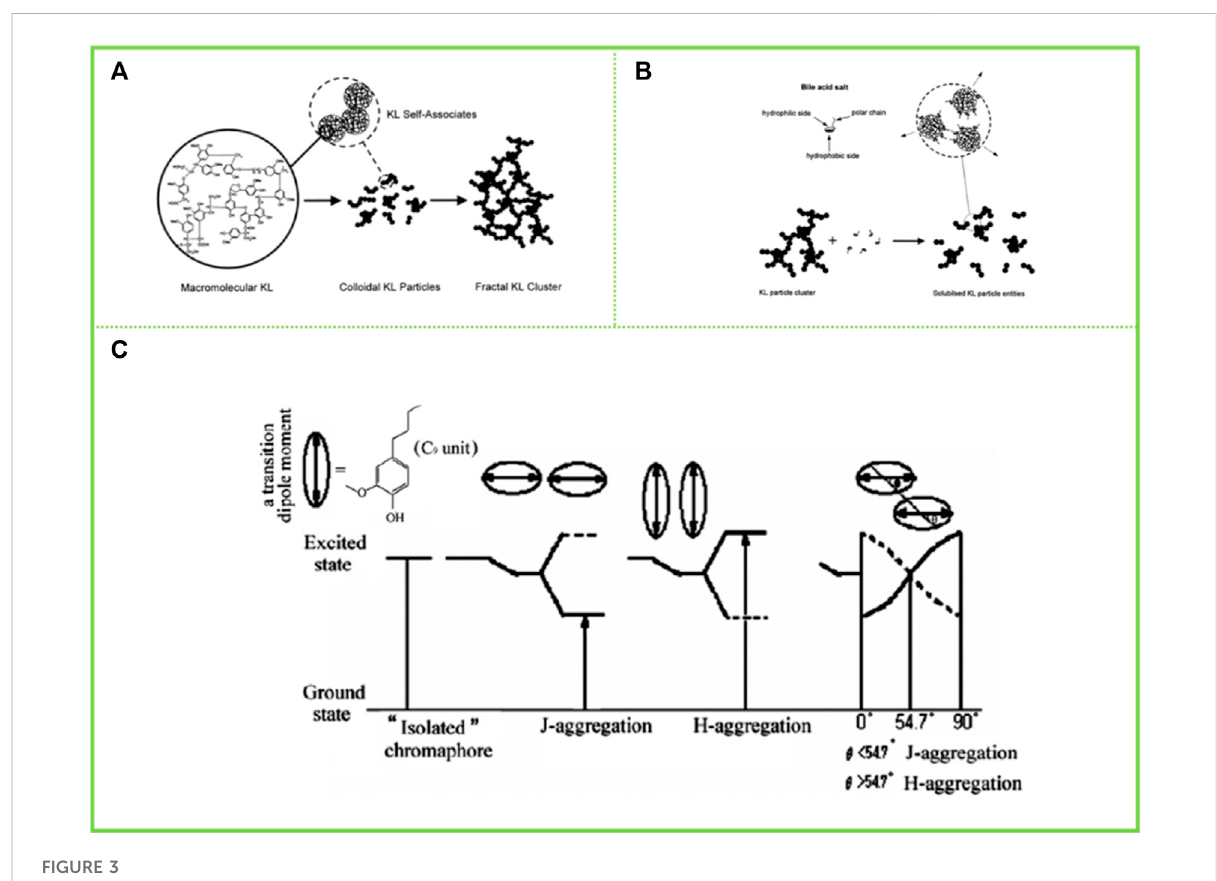
FIGURE 3 (A) schematic representation of the modes of aggregation in kraft lignin (KL) systems starting from macromolecular KL (ref 49) and fi nally reaching fractal KL clusters (Norgren et al., 2002) (B) A schematic illustration, showing the bile salt – KL interaction (Magnus Norgren 2001) (C) Schematic representation of the arrangement for H and J aggregation and their different energy levels (Deng et al., 2011). (A) Copyright 2002 American Chemical Society (B) Copyright 2001 Elsevier (C) Copyright 2011 American Chemical